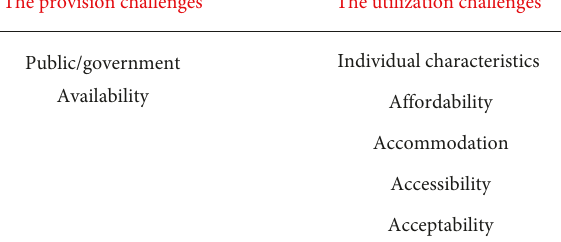
Figure 2: An overview of the scoping review’s conceptual